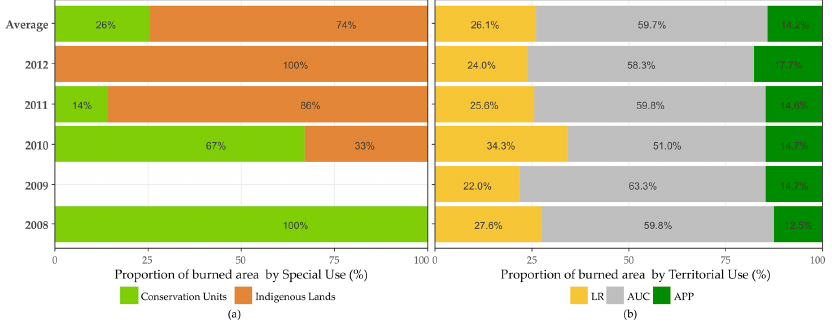
Figure 5. The proportion of burned area by land use and land cover types ( a ) and by special areas ( b ), through the years analyzed